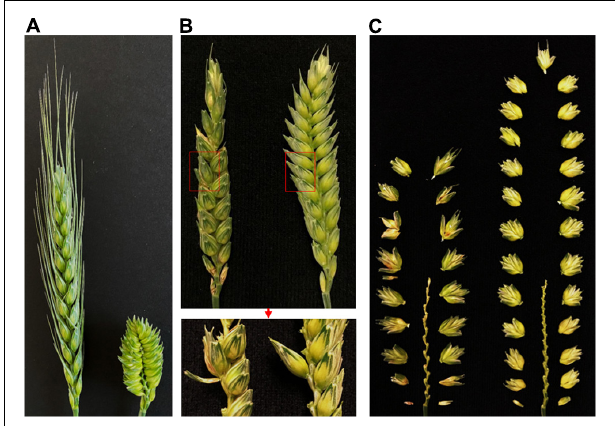
FIGURE 1 | Morphological traits of spikes in SY95-71 and CH7034. (A) Comparison of spike between SY95-71 and CH7034. The image shows no supernumerary spikelets in either SY95-71 or CH7034. (B) Dissection of supernumerary spikelets. RIL spikes were segregated with supernumerary spikelets (the left side) and without supernumerary spikelets (right). Supernumerary spikelets are shown on spikes within a red square (upper) and dissected spikes (lower). (C) Spikelet nodes on spikes. RIL were segregated to have less SNS (left) and more SNS (right). Bars, 1 cm.